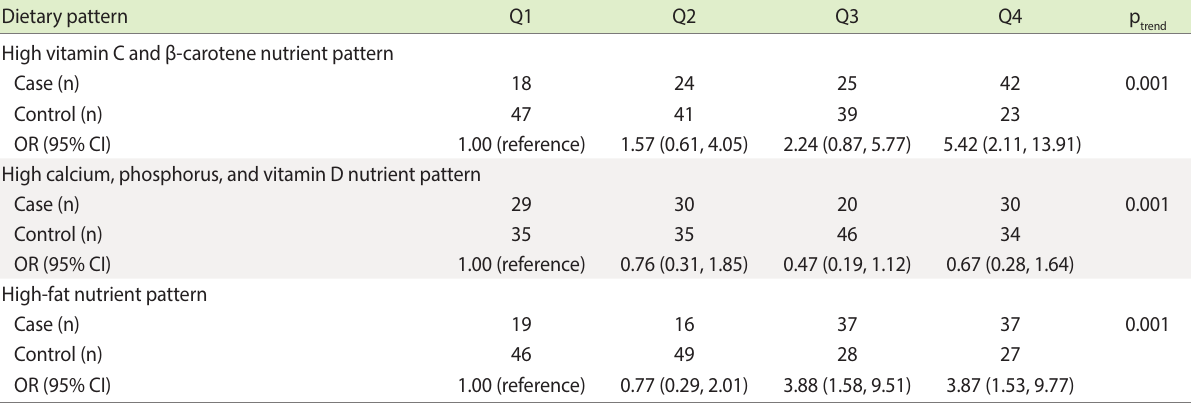
Table 3. Associations of the identified nutrient intake patterns and breast cancer risk 1 Dietary